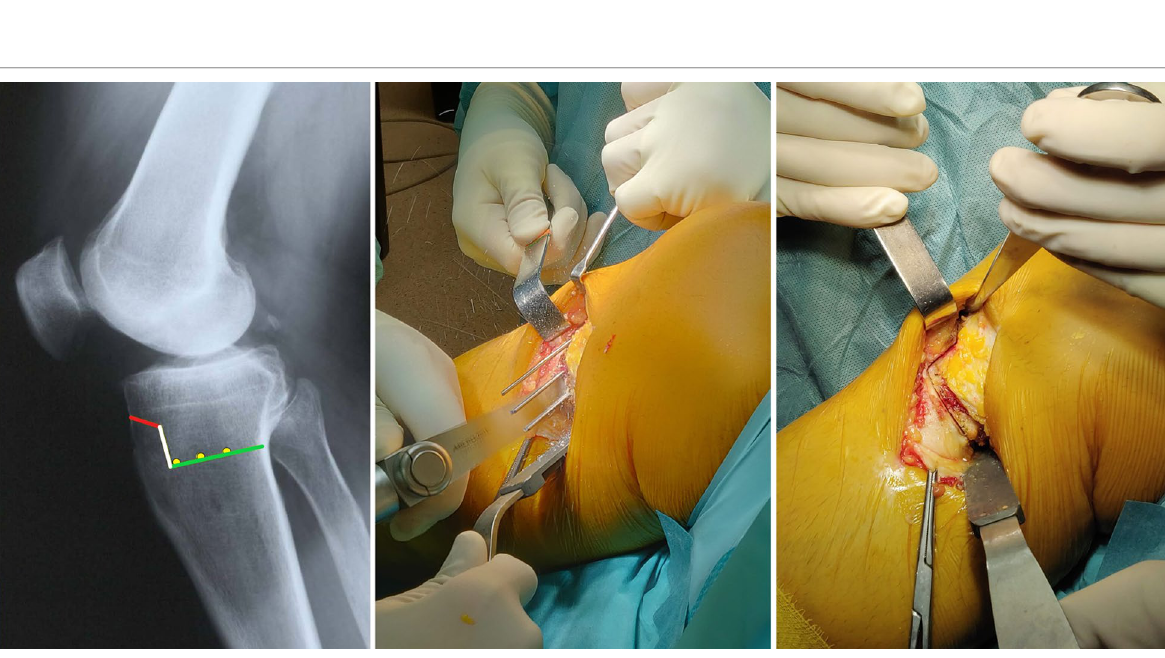
Fig. 6 On the left, a graphical representation of the three guide wires (yellow dots), the first coronal osteotomy (vertical white line), the second oblique osteotomy (red line), and the third horizontal main osteotomy, on a lateral X-ray view of a right knee. In the middle, intraoperative findings of the third horizontal osteotomy performed with an oscillating saw. On the right, the intraoperative findings of complete Z-shaped MOWHTO, in a right tibia, from medial